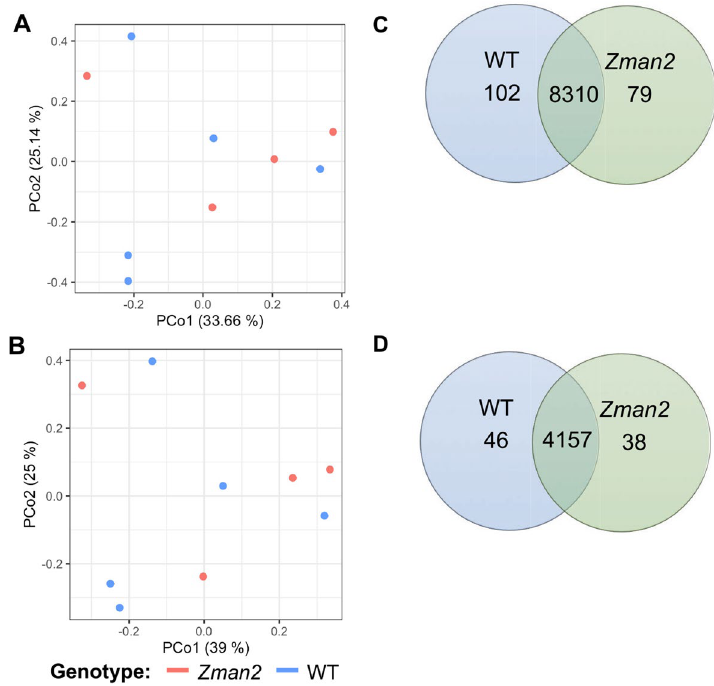
Figure 7. Principal Coordinate Analysis (PCoA) of the metabolome for all root samples in ( A ) positive mode or ( B ) negative mode using LC–MS/MS. Each point represents an individual plant sample. Percentage in the axis labels represents the eigenvalue, or percent of variation explained by that axis. Number of enriched metabolites detected using LC–MS/MS in positive mode ( C ) or negative mode ( D ), as measured by a generalized linear model at the level of p ≤ 0.05, for each genotype. Overlap are not significantly different; n = 4 ( Zman2 ) or n = 5